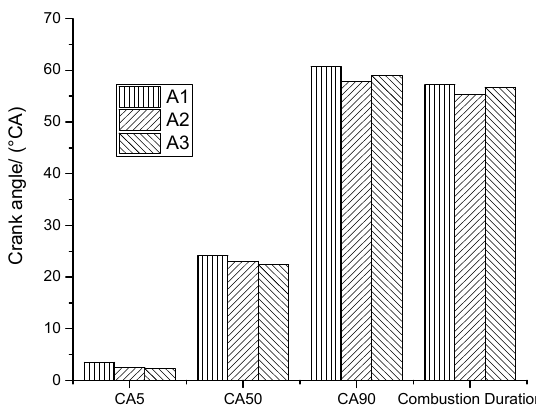
Figure 9. HRR characters for different combustion chambers at 460 kPa inlet pressure.